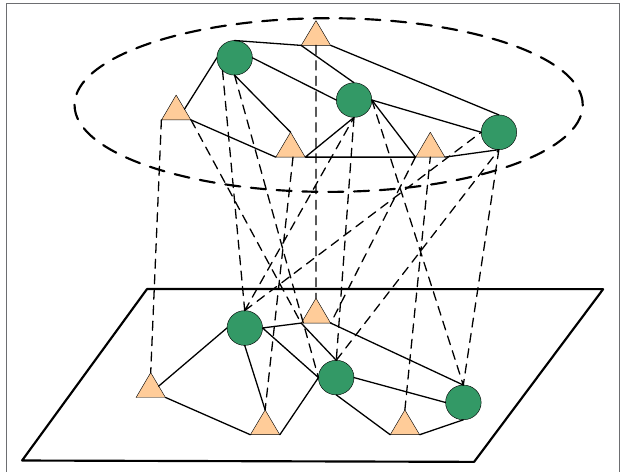
FIGURE 3 | Schematic diagram of the collaborative innovation network structure of colleges and